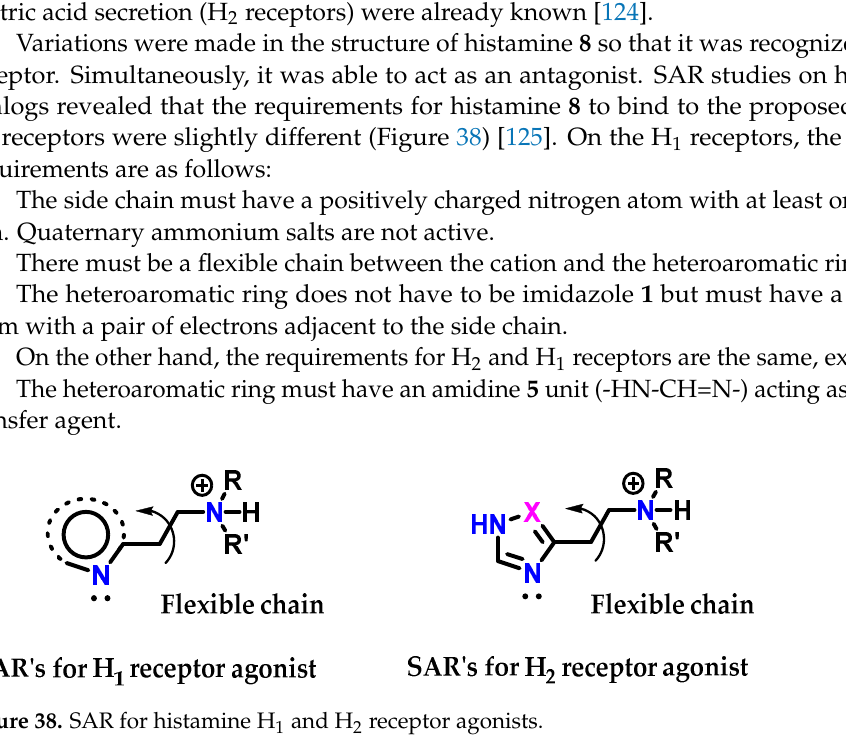
Figure 38. SAR for histamine H 1 and H 2 receptor agonists.